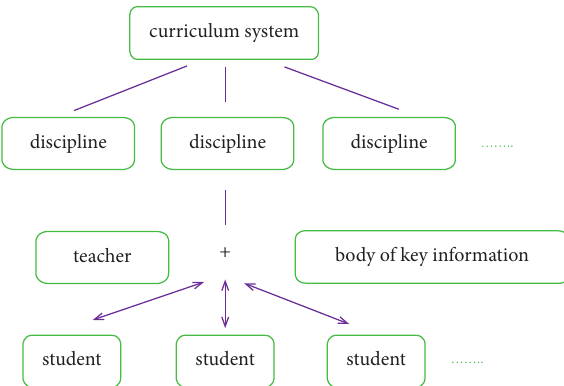
Figure 1: The hierarchical structure of traditional